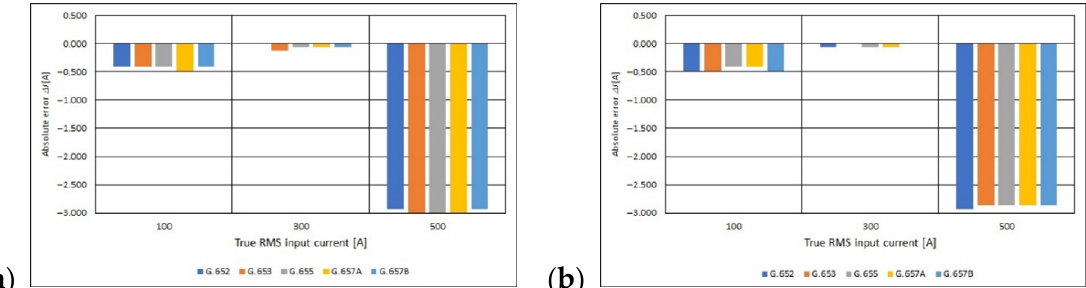
Figure 12. Values of absolute error for polarimetric current sensor with measuring coil made of the different standards of Scheme 40. ( a ) Turns measuring coil and ( b ) for 80-turns measuring coil.